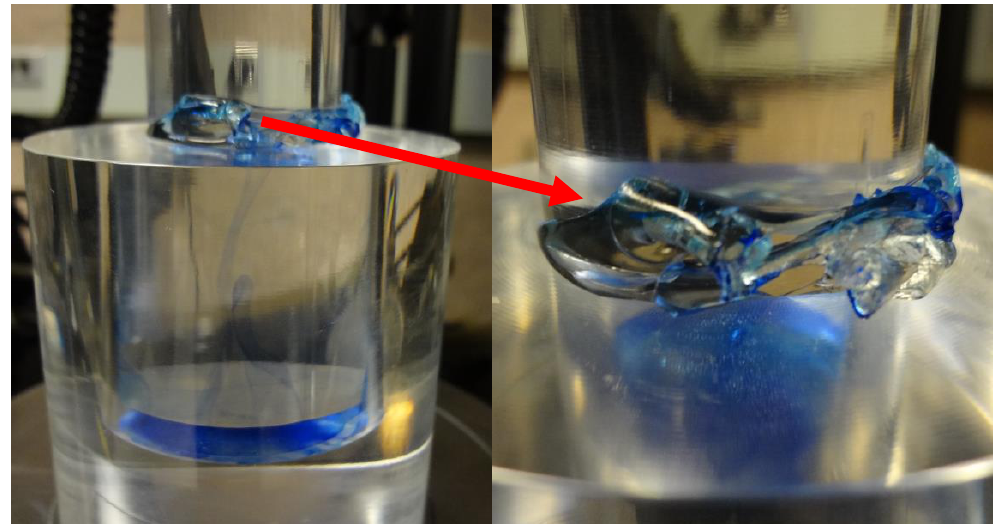
Figure 10. Confined compression of SAPS(1,2,2,9)/AAm(2,0.1,0,97) DN hydrogel. The hydrogel retains water under confined compression, but when the compression becomes too high, some parts from the edges of the sample climb up the gap. This behavior was observed in all tough DN hydrogels studied.